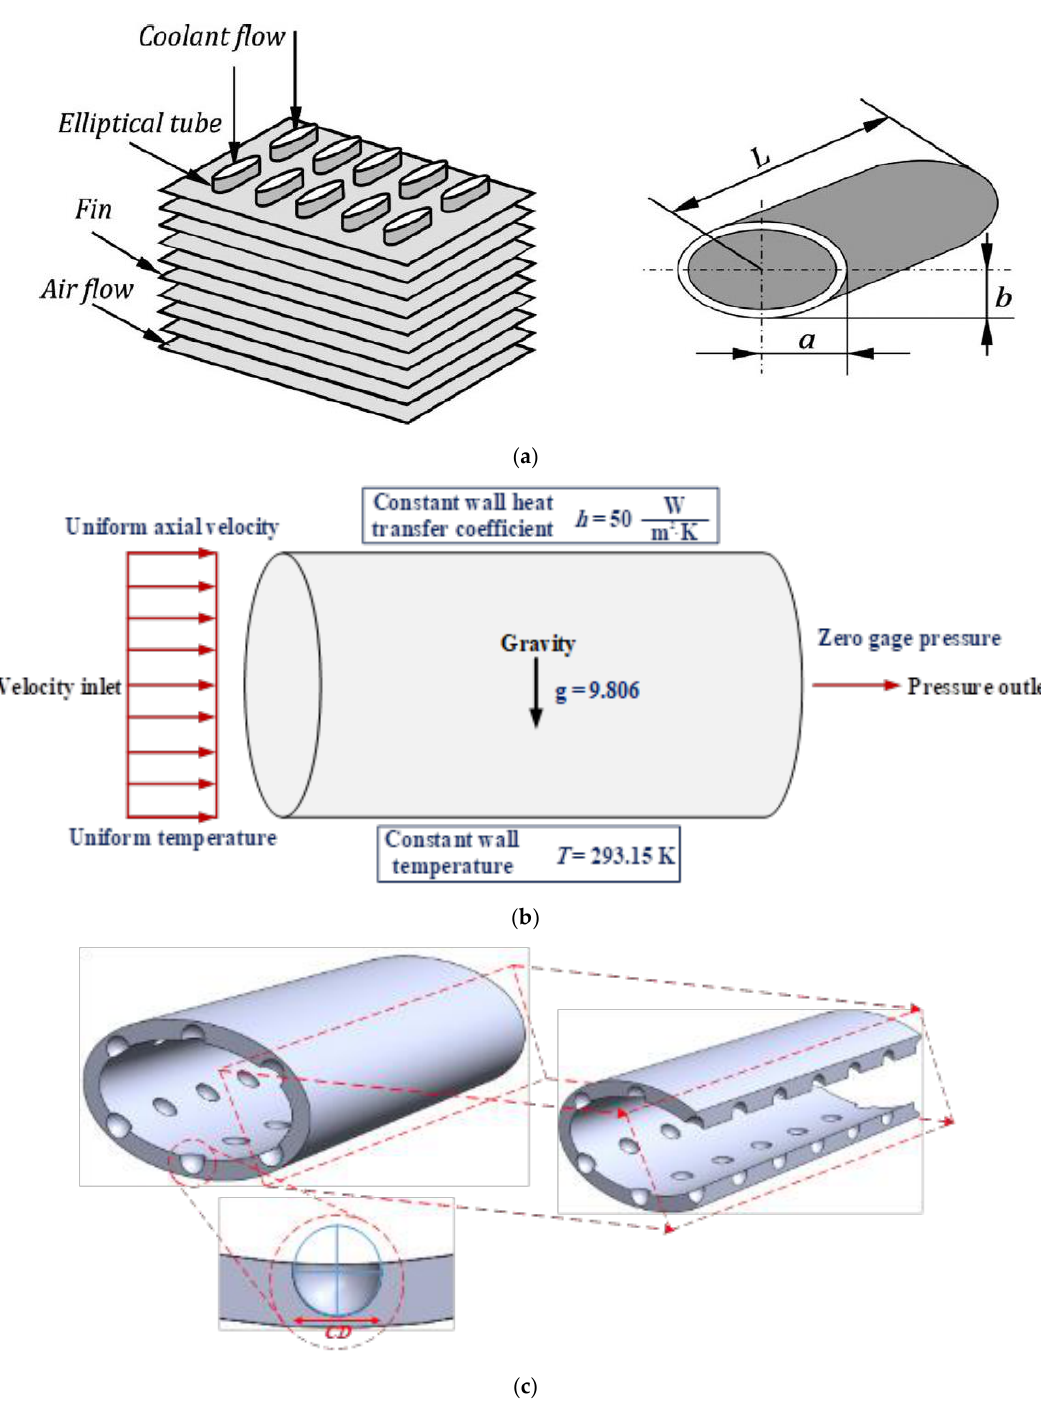
Figure 1. Schematic of ( a ) heat exchanger with elliptical corrugated tubes, ( b ) elliptical tube and boundary conditions, and ( c ) elliptical corrugated tube.